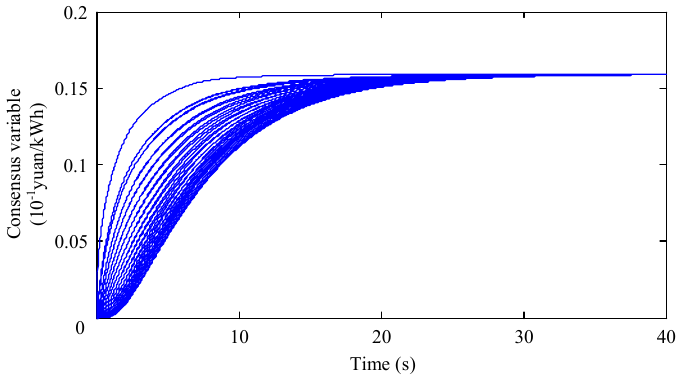
Figure 9. Consensus variables λ v in cluster 4.